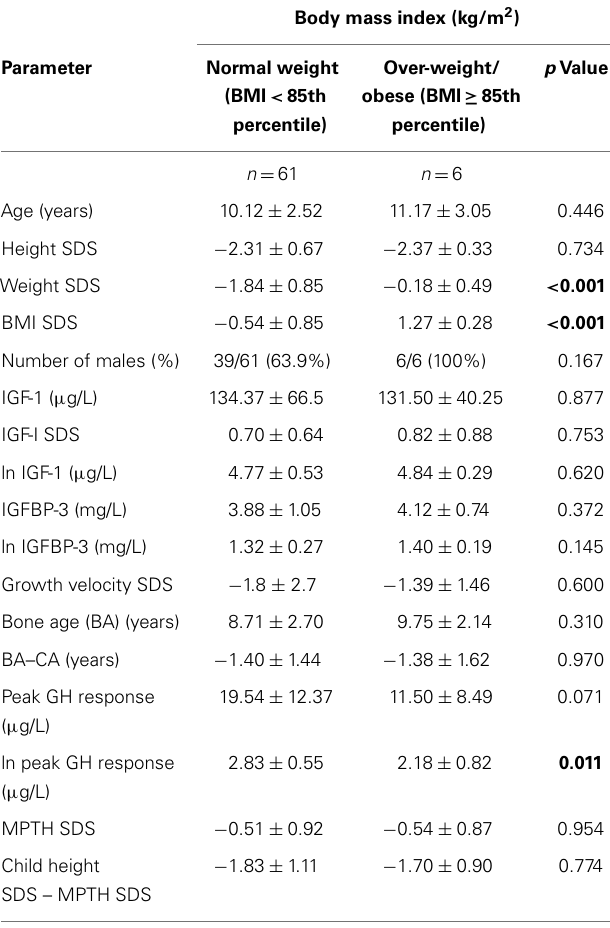
Table 1 | Characteristics of prepubertal patients stratified by body mass index percentile